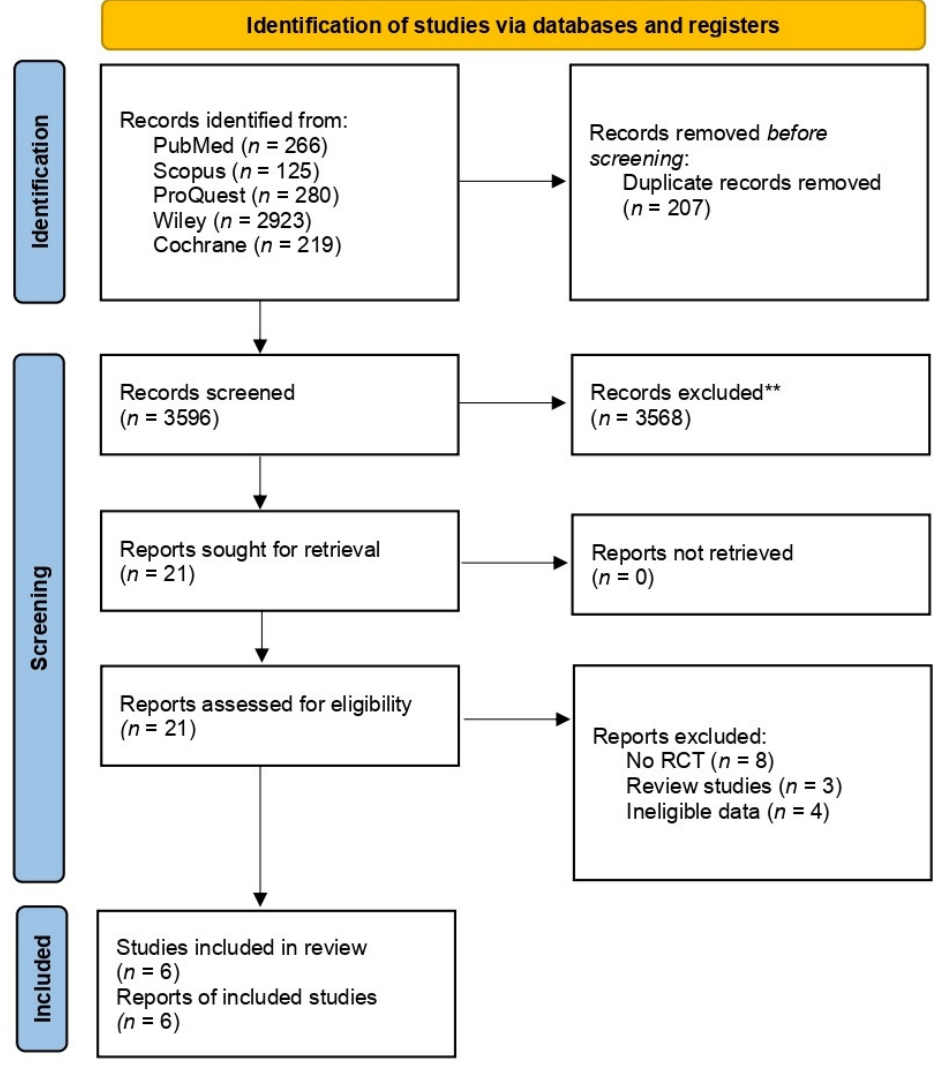
Figure 1. PRISMA flow diagram.